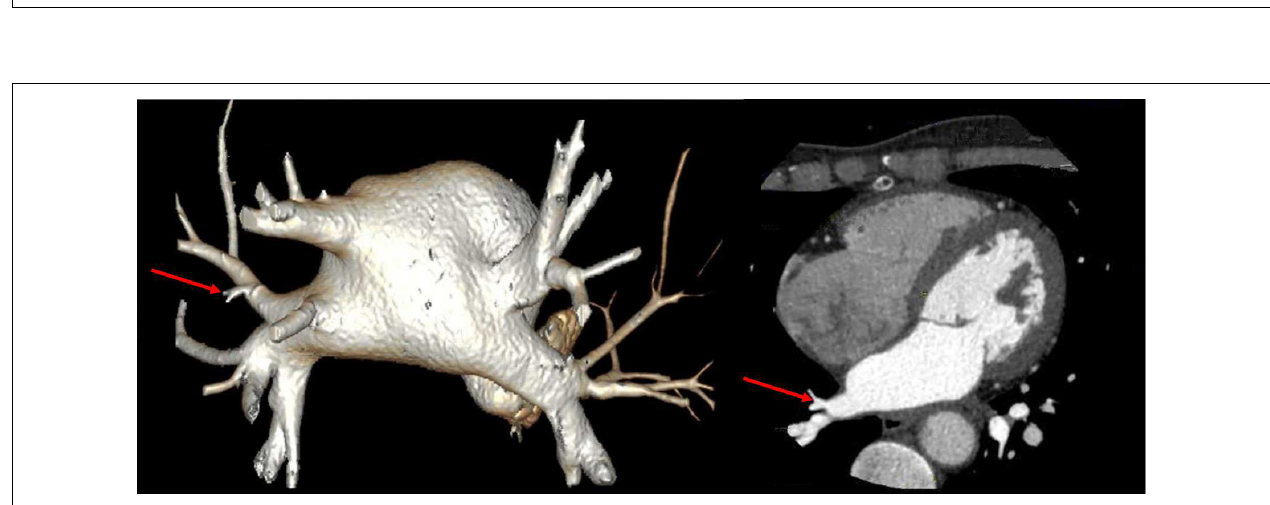
FIGURE 3 | CT angiography (CTA) of left atria-pulmonary vein showed the middle branch of the right pulmonary vein was variable.